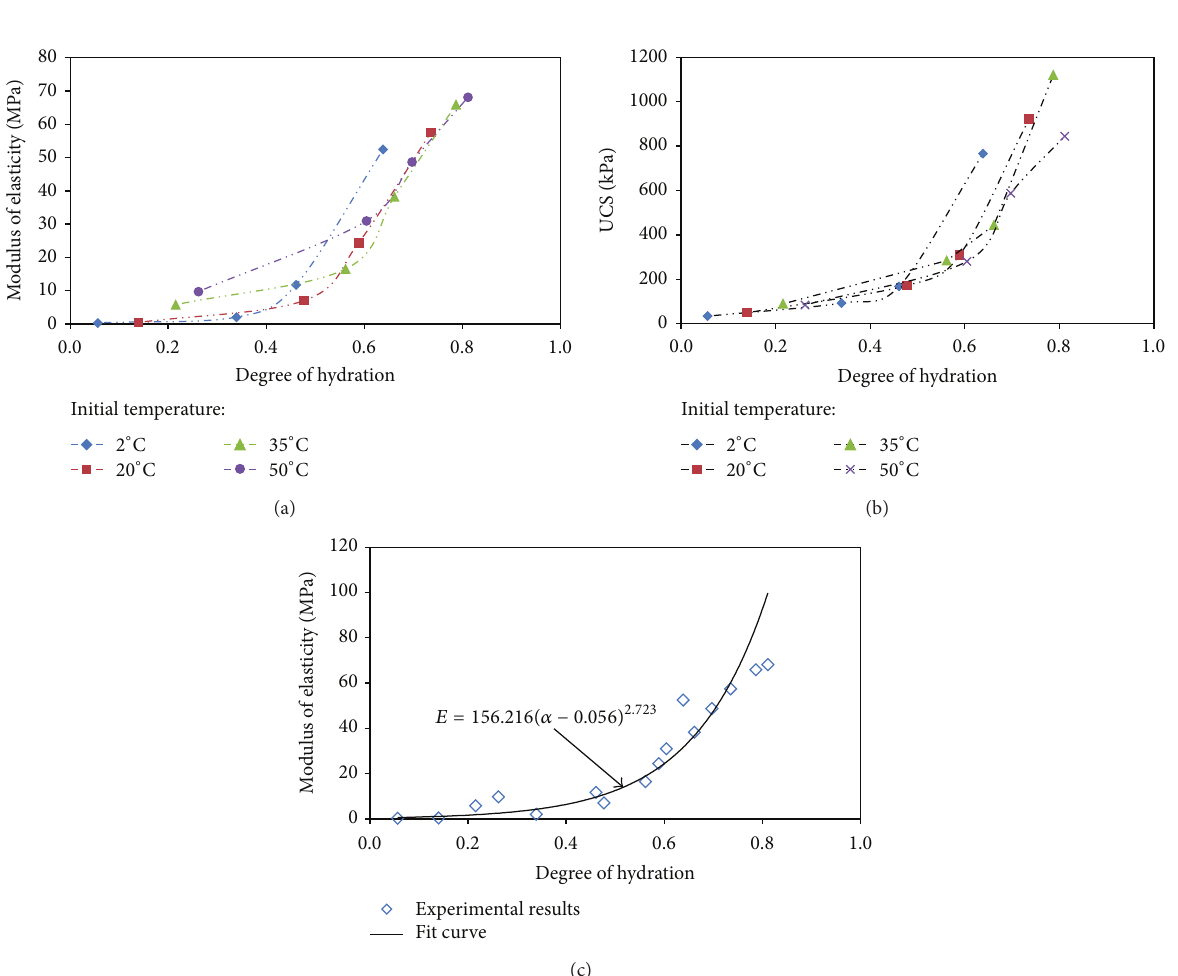
Figure 10: Effect of initial temperature on the relationship between 𝐸 , UCS, and degree of hydration: (a) relationship between 𝐸 and degree of hydration, (b) relationship between UCS and degree of hydration, and (c) the scatter plot of the experimentally determined versus predicated trend line for 𝐸 and degree of